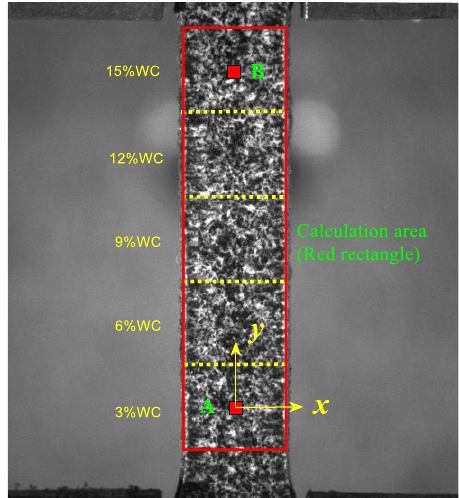
Figure 4. Schematic diagram of laminated Cu/WC P functionally gradient material specimen and DIC calculation area (red rectangle).